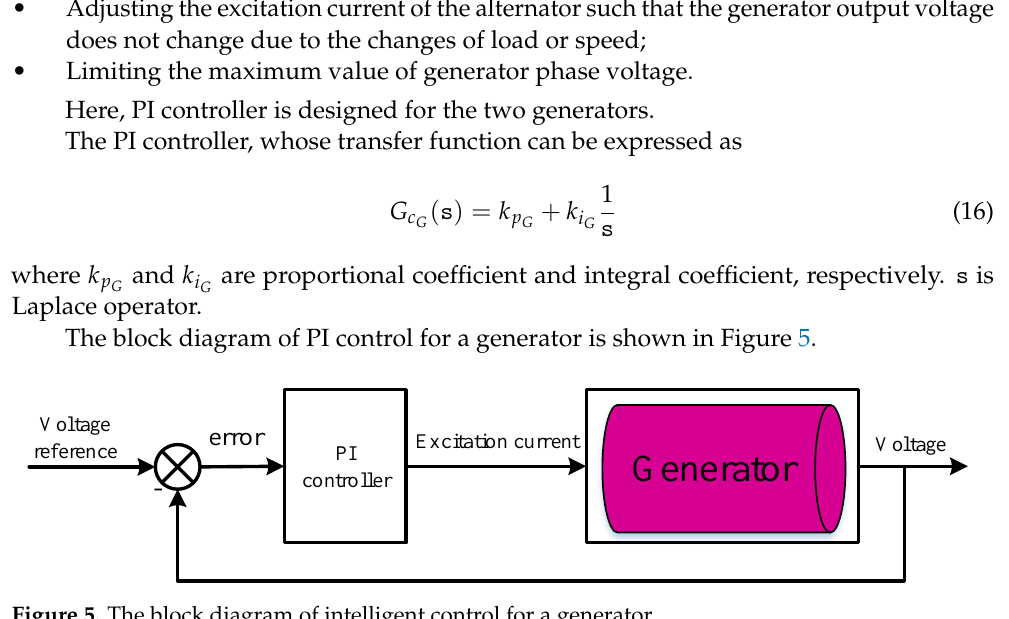
Figure 5. The block diagram of intelligent control for a